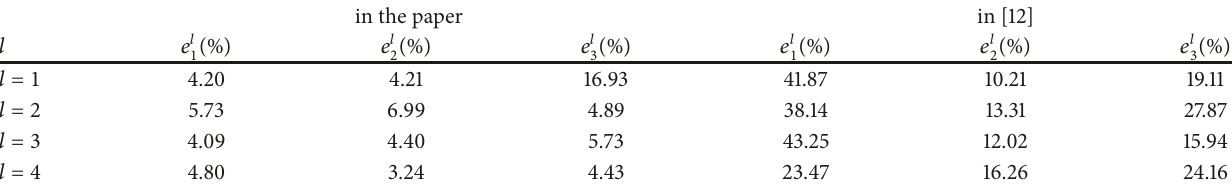
Table 4: The relative errors under the optimal switched times and system